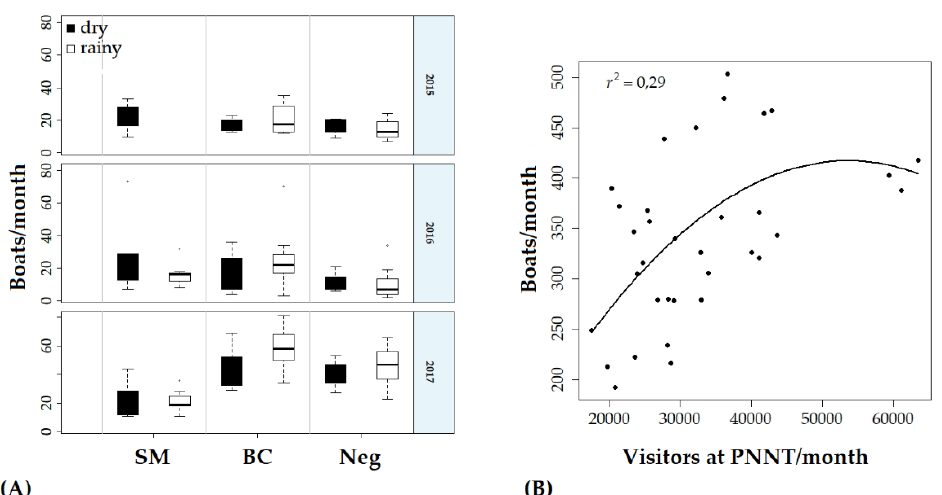
Figure 3. ( A ) Number of boats per month visiting Santa Marta, Bahía Concha, and Nenguange between seasons and ( B ) quadratic regression model between the number of boats and visitors per month in PNNT. Source: [30,43].